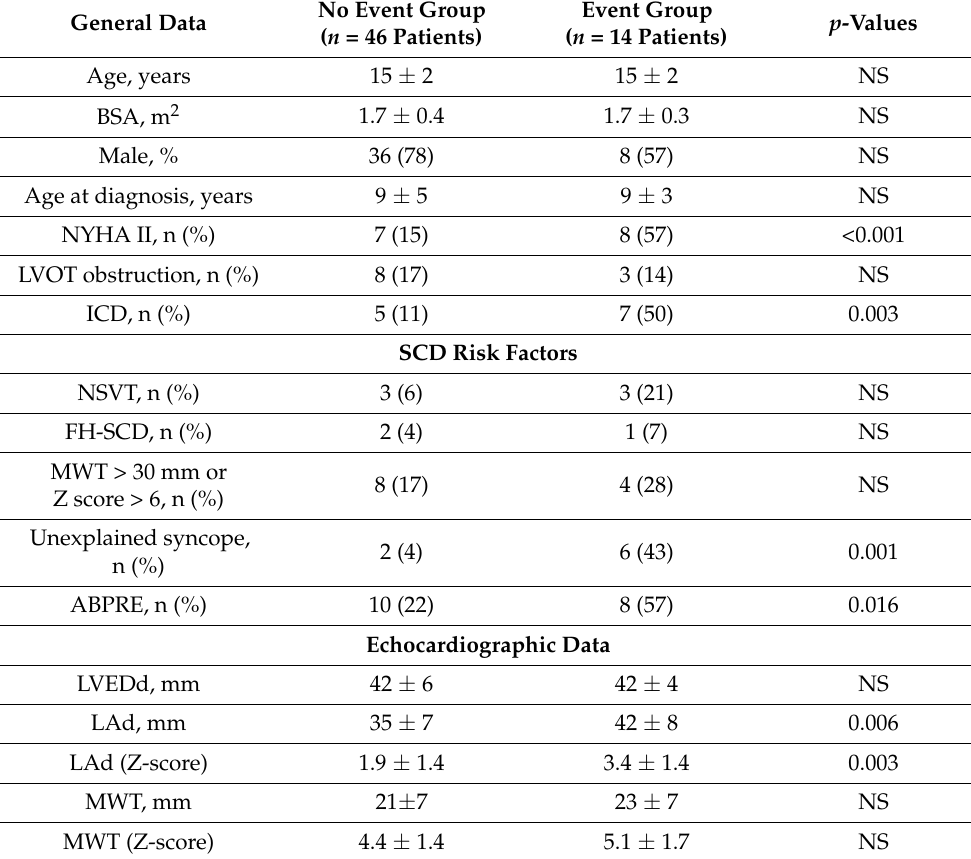
Table 3. Comparison between main clinical variables between HCM patients who did not experience (No Event Group) or experienced (Event Group) adverse